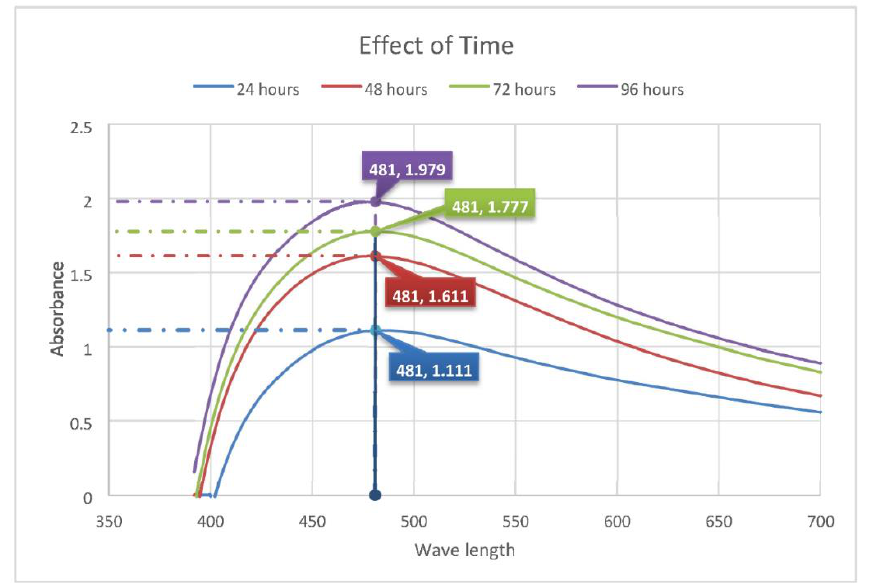
Figure 7. Stability of the synthesized AgNPs. The absorbance peaked at 1.111, with the SPR positioned at 481 nm at 24 h. The maximum absorbance was observed at the 96-h mark showing an absorbance of 1.979. At the 48-h mark, the absorbance was 1.611 at an SPR of 481, while at the 72-h mark, the absorbance was 1.777 at an SPR of 481. Little to no absorbance was observed for all of them below 390 nm.